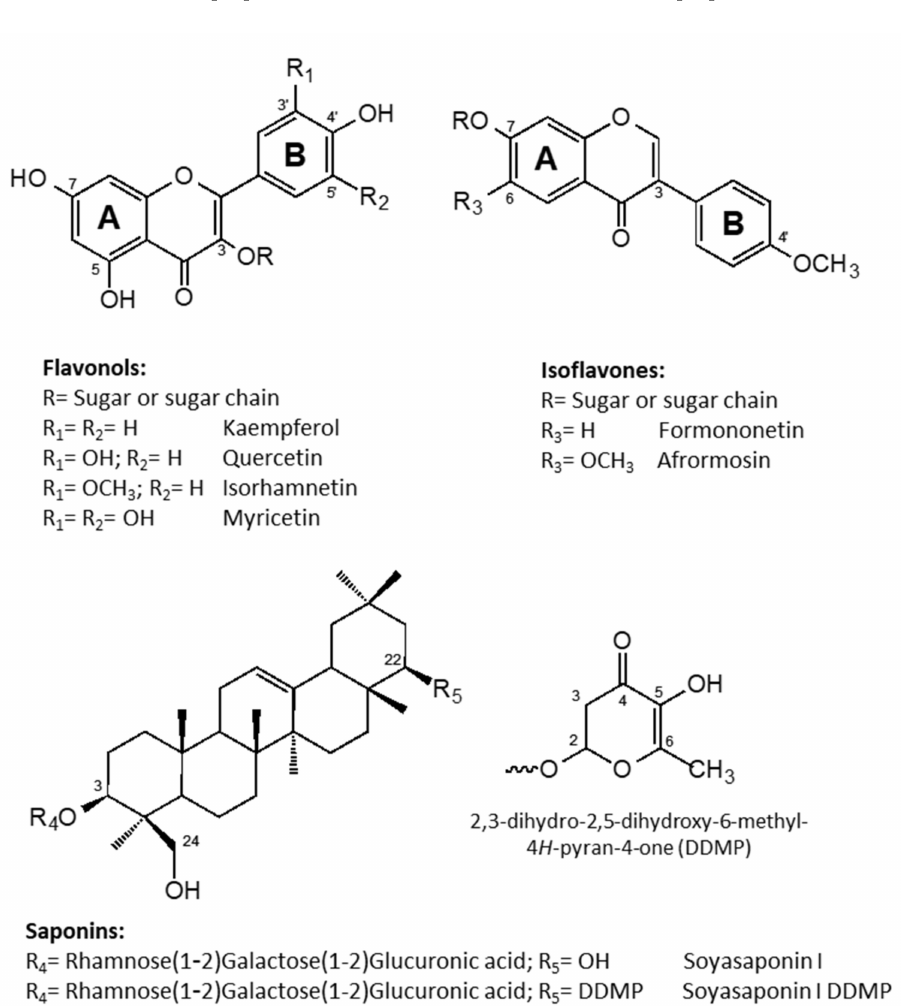
Figure 2. Chemical structures of the most abundant specialized metabolites detected in the flowers and leaves of H. coronarium